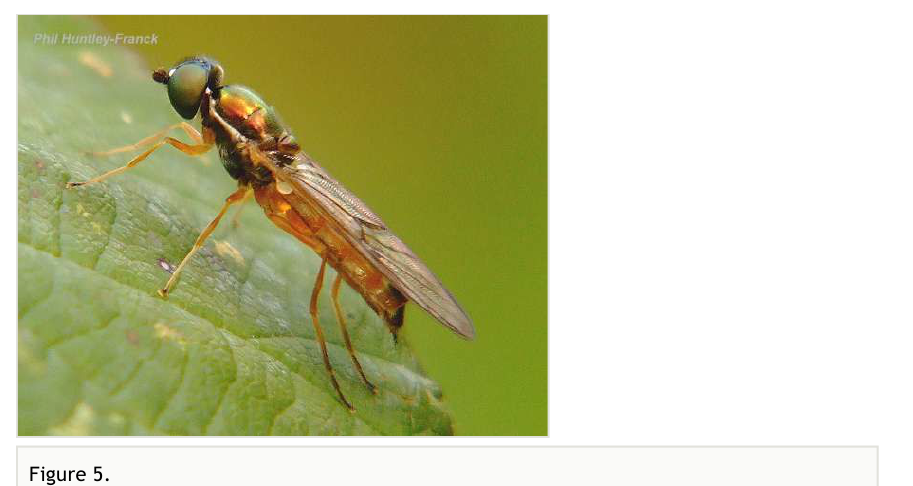
Sargus decorus . Photograph by Phil Huntley-Franck, used with